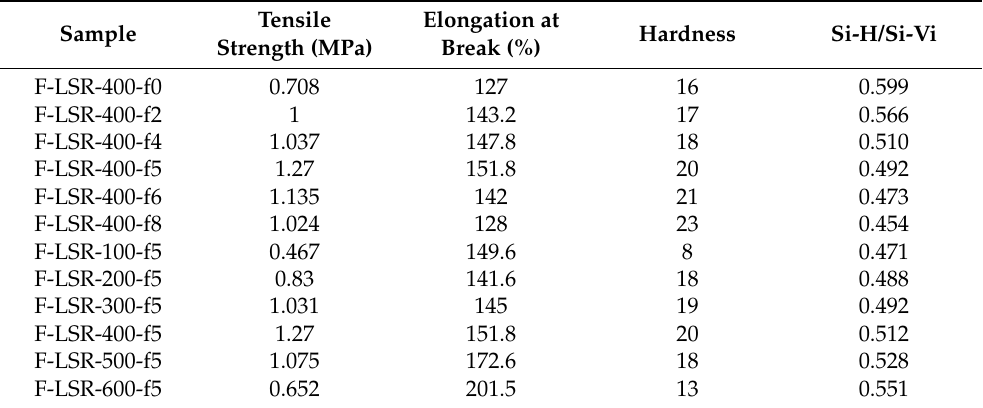
Figure 7. The mechanical properties of F-LSR ( a ) with a different chain-length and ( b ) with different fluorine ratios. Table 4. Mechanical property data of F-LSRs, and information on the Si-H/Si-Vi ratios calculated from the 1 H-NMR spectrum.